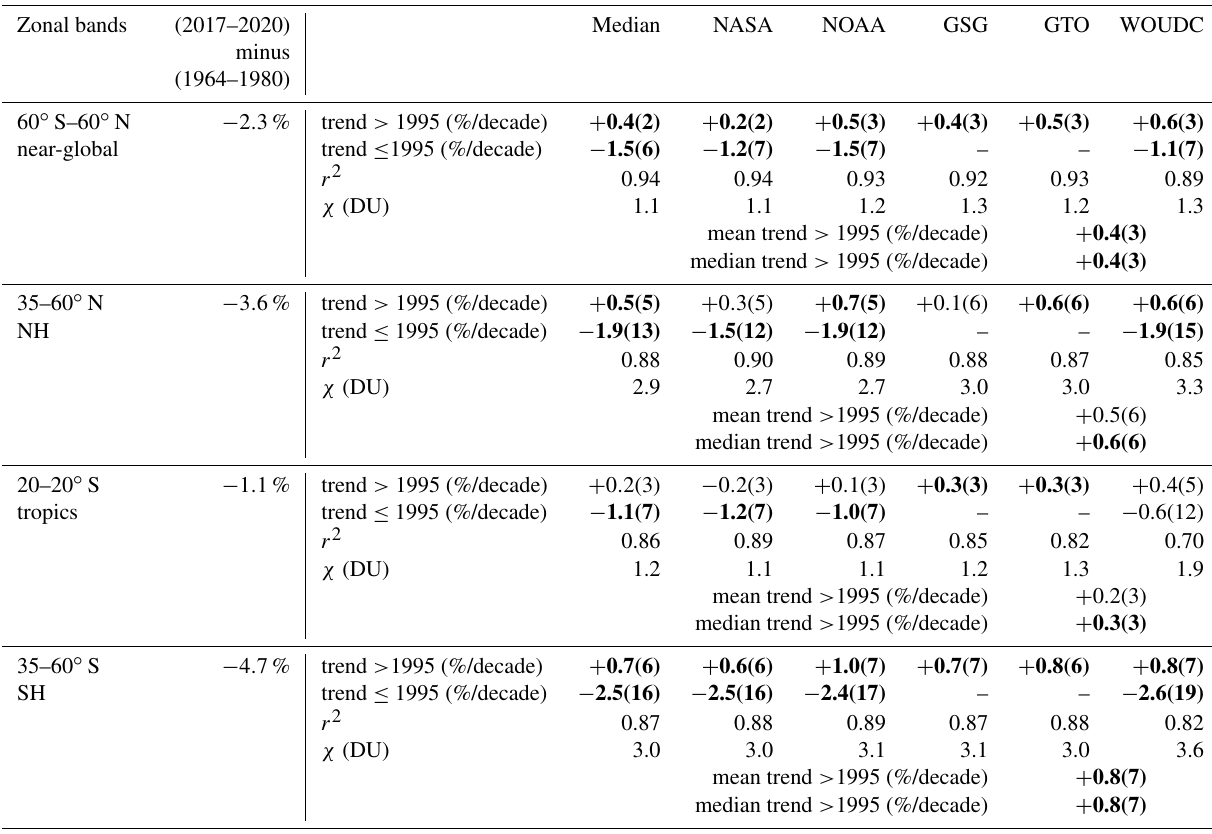
Table 3. 1979–1995 and 1996–2020 annual mean total ozone trends in various broad zonal bands. Uncertainties are given as 2 σ ; trends in bold have an absolute magnitude equal to or larger than 2 σ . r 2 is the square Pearson correlation between time series of observations and MLR and χ the residual defined as χ 2 = (cid:80) i (obs i − mod i ) 2 / ( n − m ), where obs i denotes the observations, mod i the MLR model, n the number of data (years) in the time series, and m the number of parameters fitted. All results are obtained using the full MLR. The second column shows the percent difference of the current total ozone level (2017–2020) with respect to the period before 1980 derived from the median time